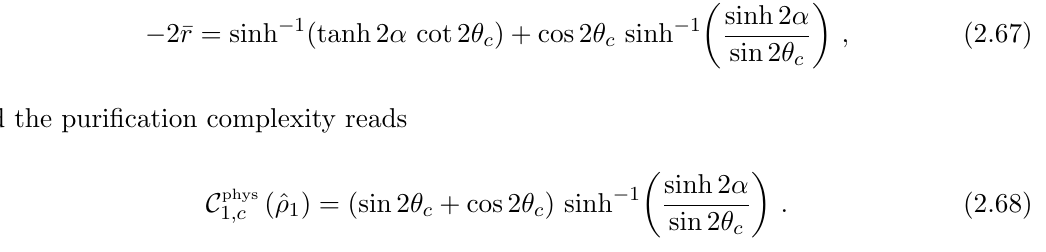
Figure 2 . Possible values for the pure state complexity C phys function of (cid:18) , for all possible sign combinations according to eq. (2.61) for (cid:12)xed values of (cid:22) r and (cid:11) . The complexity of the mixed state puri(cid:12)ed by j 12 i is obtained by minimizing over the uppermost envelope of each of these